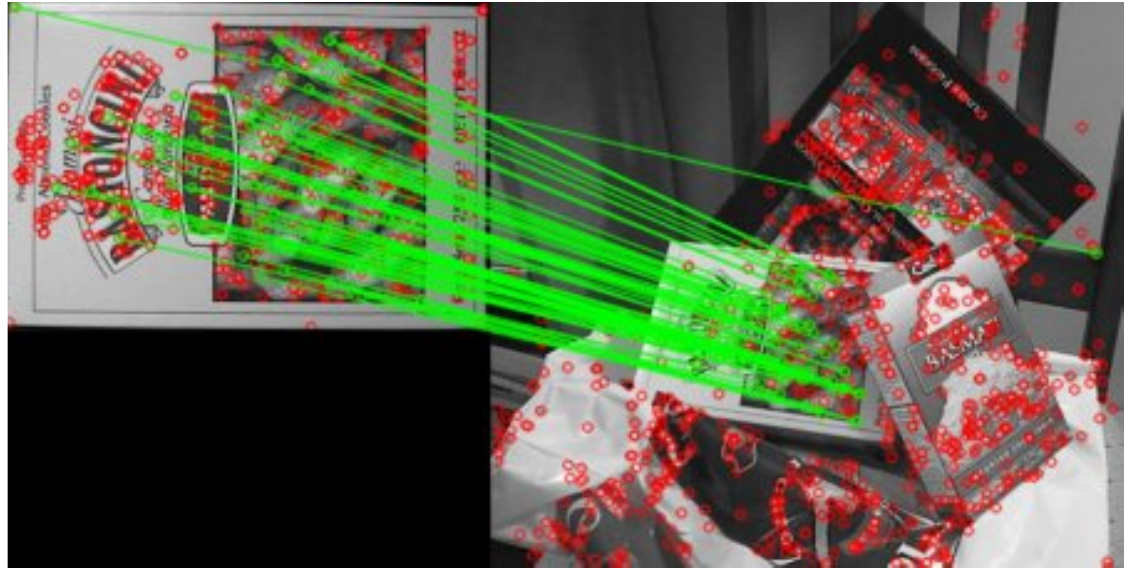
Figure 3. Feature detection using the SIFT algorithm. The red dots are the features detected by the algorithm, while the green lines are the Euclidean distance vectors between the features. Source: OpenCV Documentation [41].